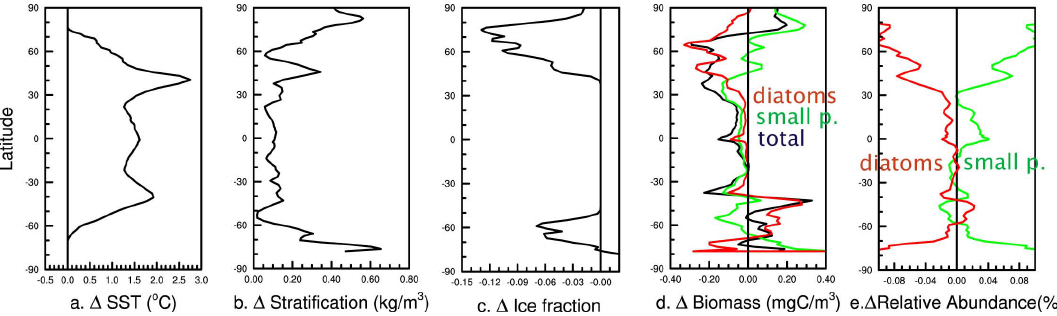
Fig. 3. Zonal mean response to climate change (calculated as difference from years 1980–1999 to 2080–2099) of the: (a) sea surface temperature in ◦ C, (b) fractional change in sea surface stratification, defined as surface minus 200m density (kg/m 3 ), (c) the ocean area covered by sea ice in 10 12 m 2 per degree, (d) total (black), small phytoplankton (green) and diatom (red) biomass (mgC/m 3 ) and (e) diatom (red) and small phytoplankton (green) relative abundance (no units).